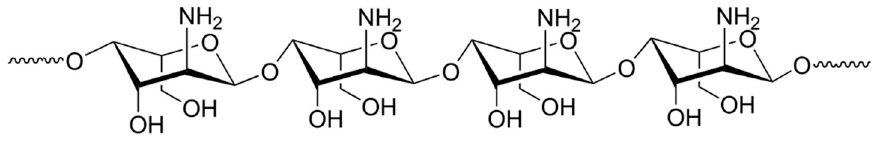
Figure 3. The structural unit of chitosan.